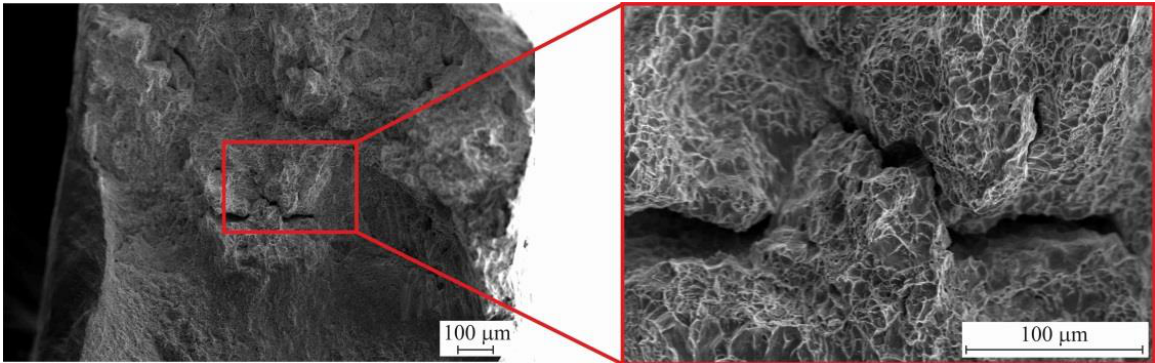
Figure 18. Fractographic images after uniaxial tension of bimetallic layered macrocomposite. Fracture analysis showed that intergrain fracture occurs. At the same time, the